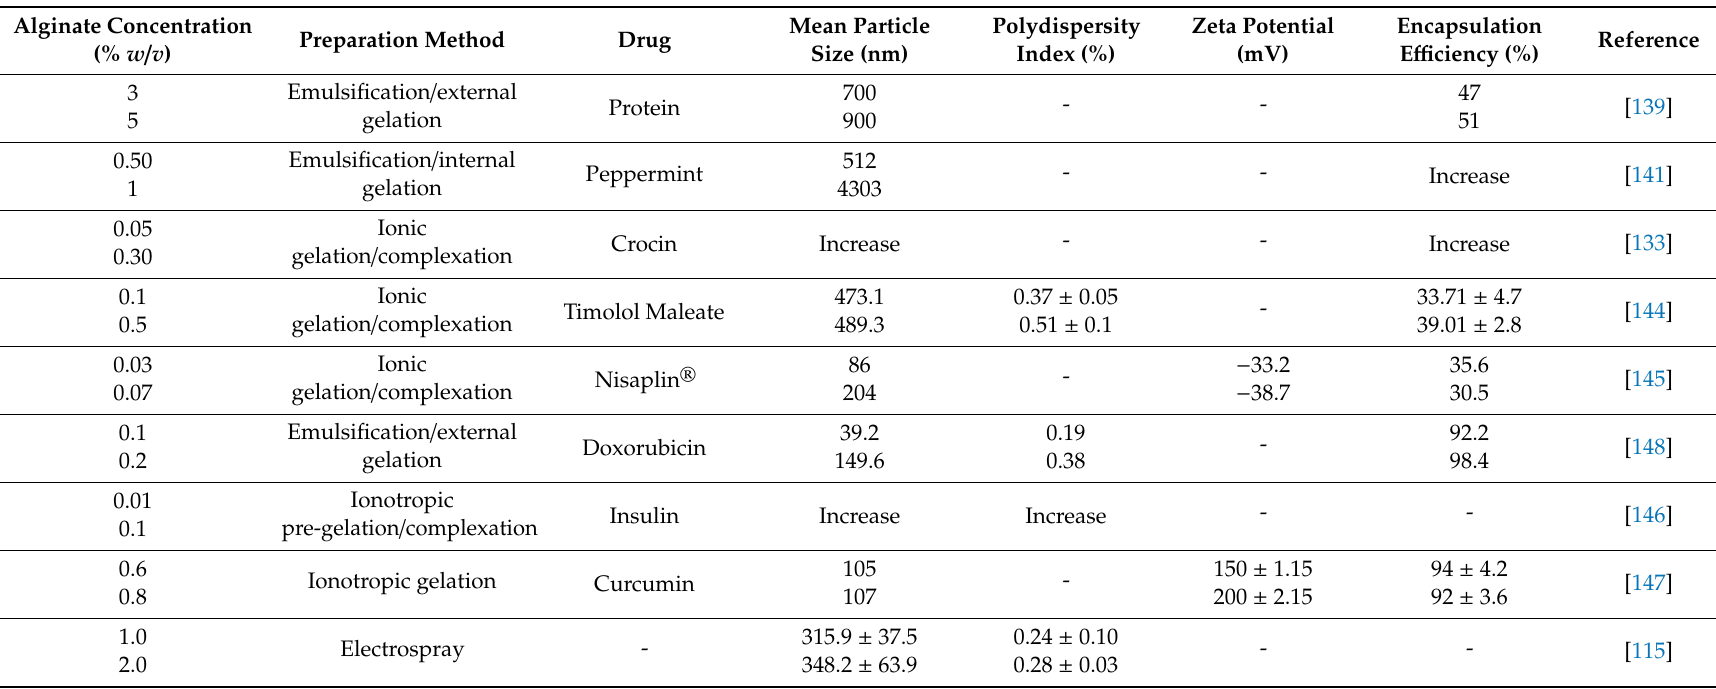
Table 3. The influence of alginate concentration on the properties of its